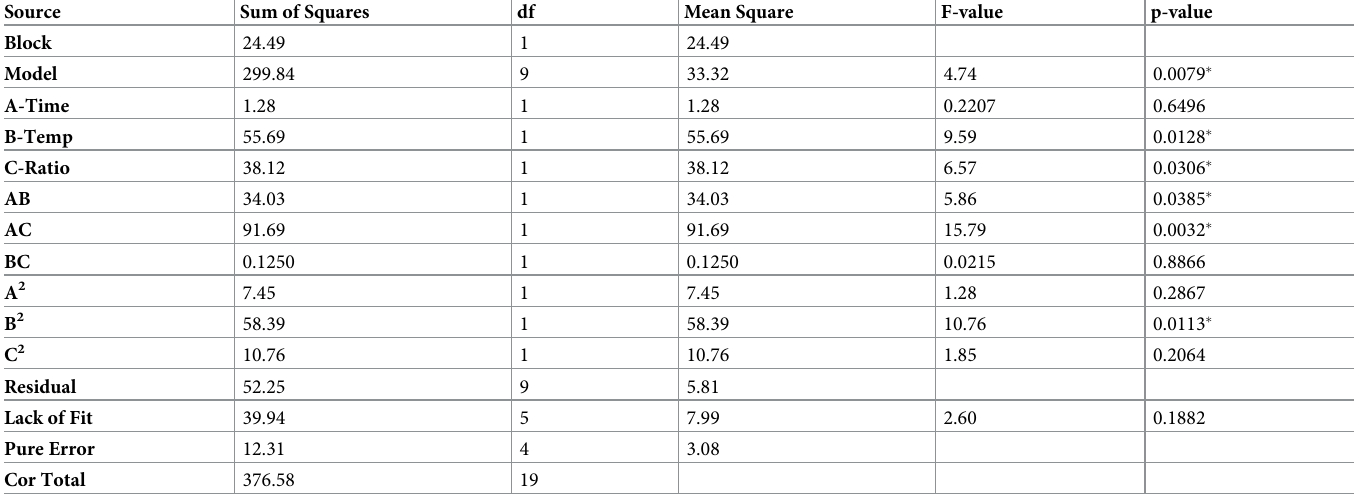
Table 3. Analysis of variance for a fitted quadratic